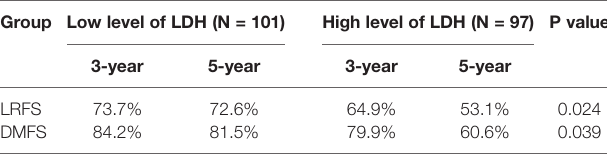
TABLE 3 | Recurrence Patterns for all the patients with pretreatment serum LDH ≤ and > 178 U/L. Group Low level of LDH (N = 101)